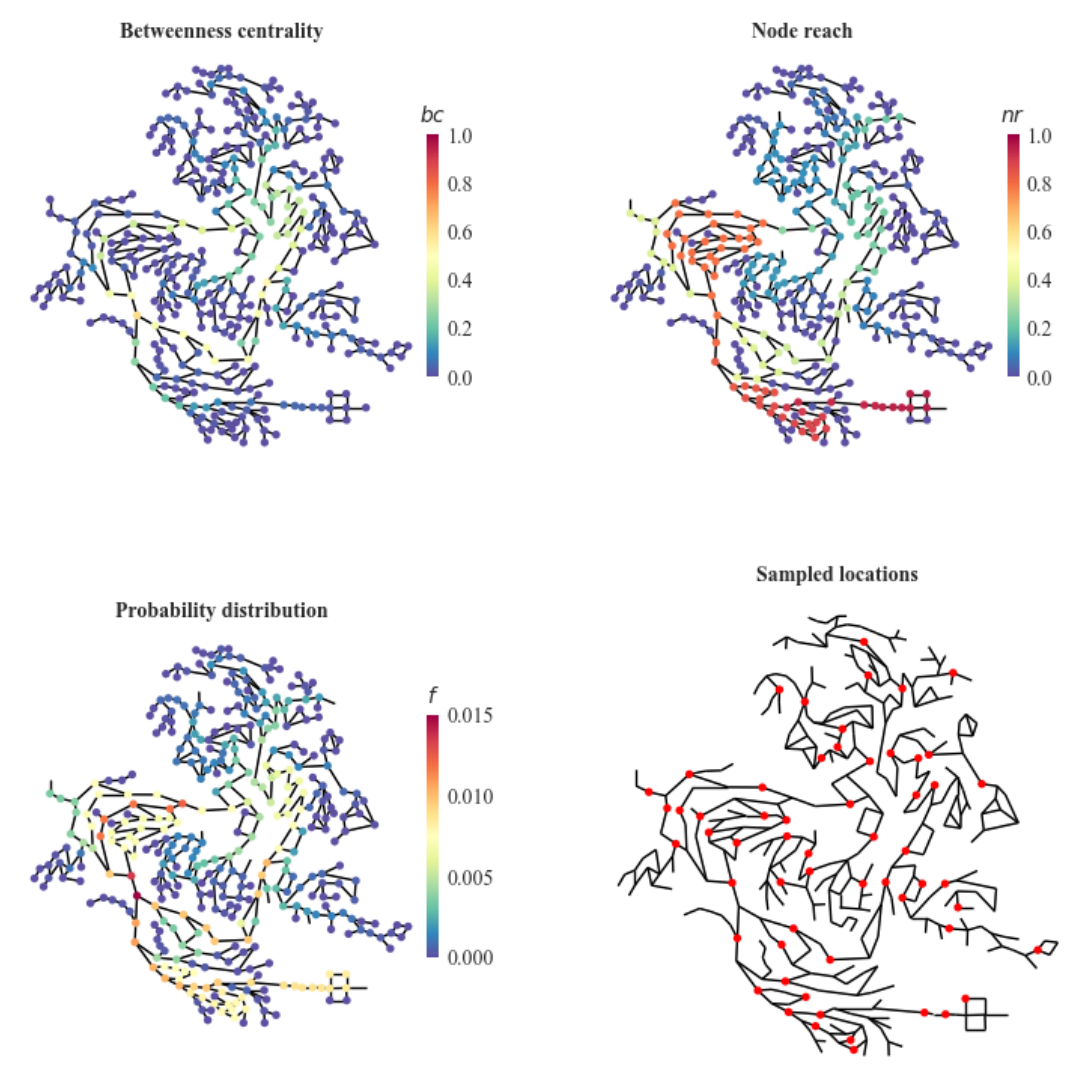
Figure 4. Betweenness centrality, node reach, probability distribution of sampling choice, and the final sampled locations with 𝑙 𝑙𝑖𝑚 = 1 .